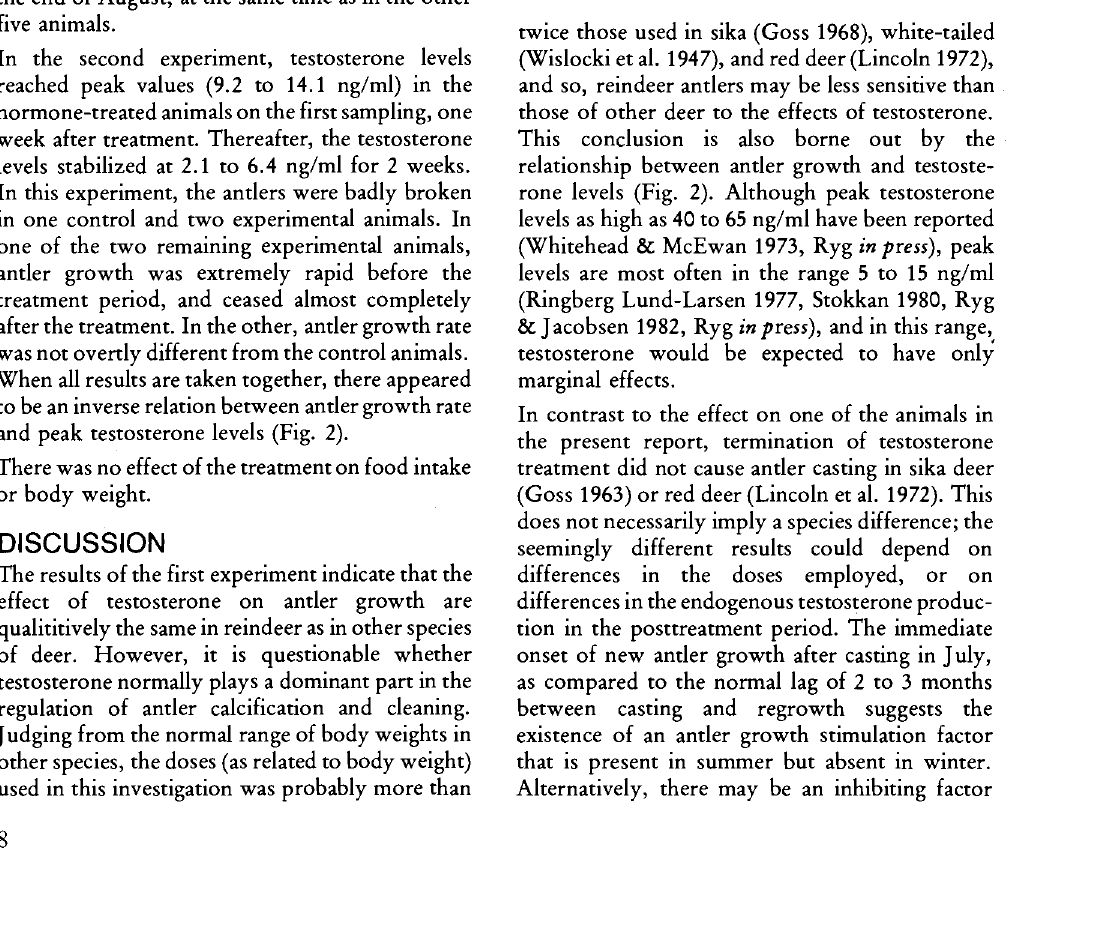
Figure 2. Relationship between maximum testosterone level and antler growth during treatment with testosterone propionate (19 June to 13 July and 22 June to 14 July in two experiments). Sammenheng mellom maksimale testosteron- nivder og gevirvekst iperioder med testosteron- behandling (19. juni til 13. juli, og 22. juni til 14. juli i to eksperimenter). twice those used in sika (Goss 1968),